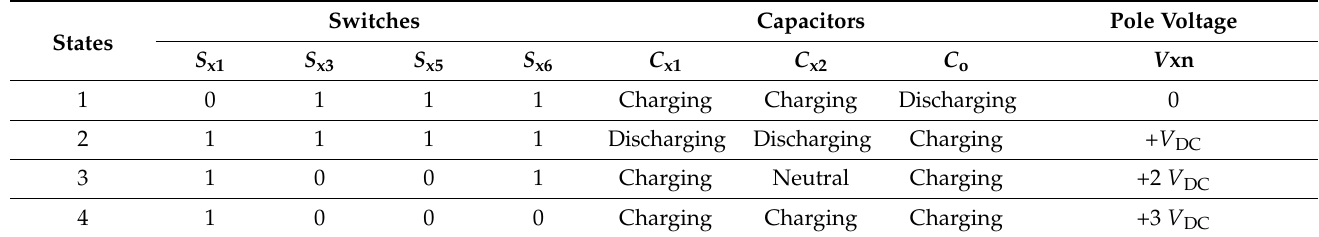
Table 2. Switching states of the proposed three-phase rectifier.